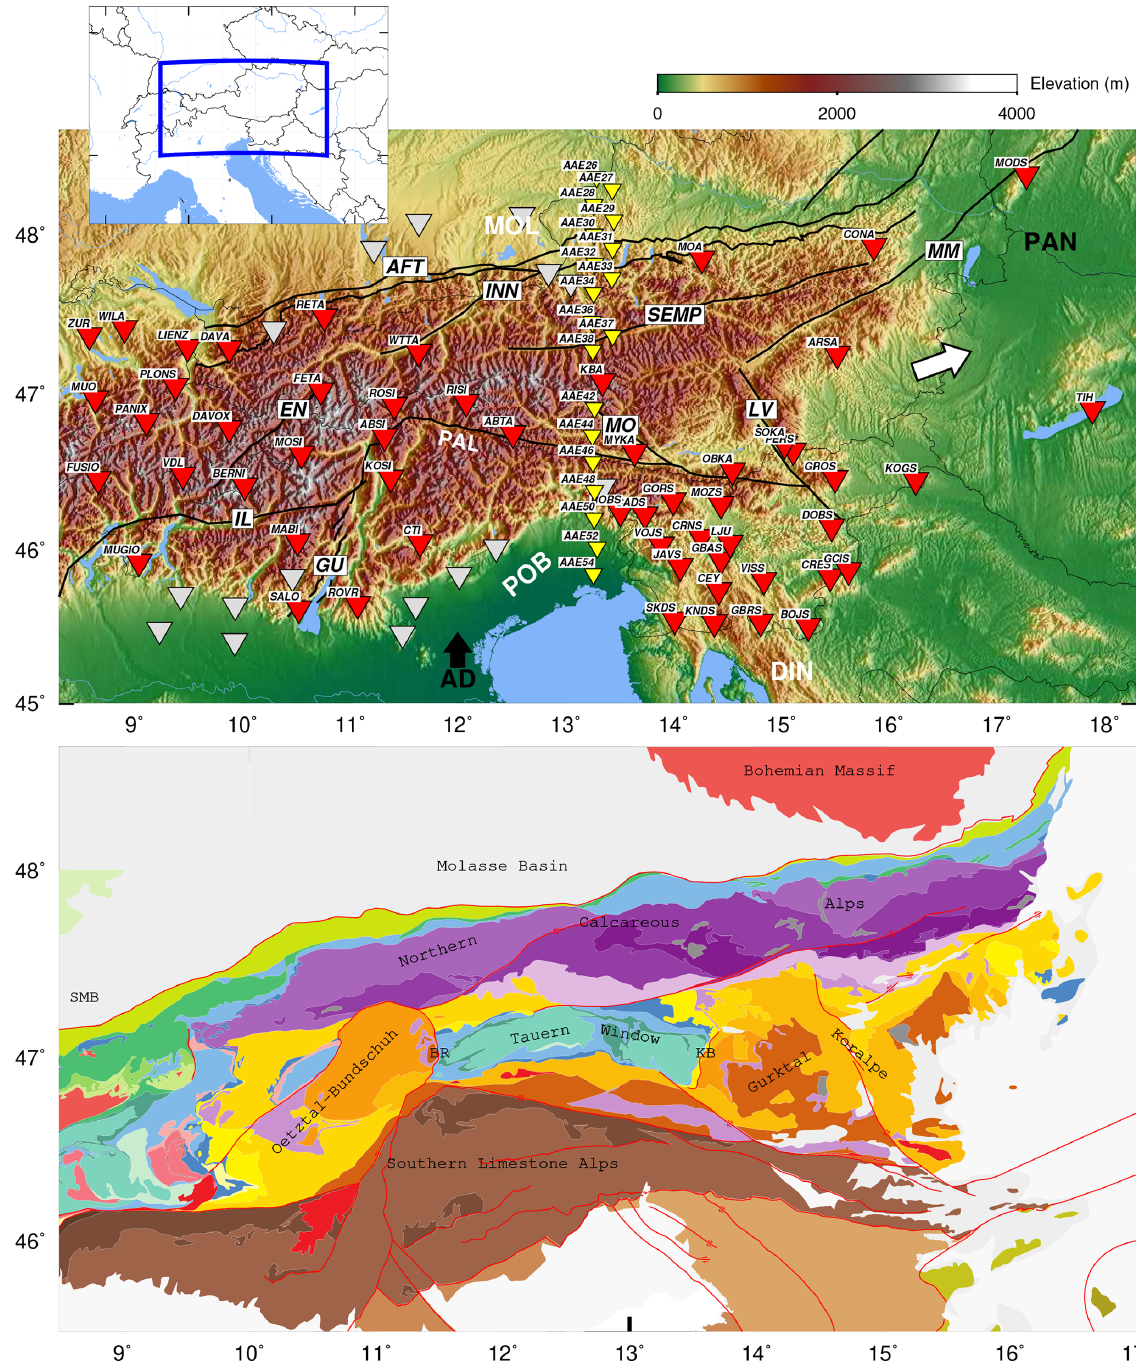
Figure 1. Study region in the Eastern and Southern Alps. Top: permanent stations are marked in red and grey, and the 19 EASI stations used are shown in yellow. Main faults of the region are represented by black lines. The faults are indicated as follows. AFT: northern Alpine Front Thrust, INN: Inntal, SEMP: Salzach–Ennstal–Mariazell–Puchberg, MM: Mur–Mürz, LV: Lavant Valley, MO: Mölltal, GU: Giudicarie, IL: Insubric, EN: Engadine, PAL: Periadriatic line. MOL: Molasse Basin, PO: Po Basin; PAN: Pannonian basin. DIN: Dinarides mountain belt. The black arrow shows the convergence vector of the Adriatic Plate (AD) with respect to the European Plate (EU). A white arrow illustrates the direction of eastward escape of the Alcapa tectonic block (see Sect. 6.4). After the different selection criteria, the stations shown in red and yellow were entered into the inversion (see text). Bottom: tectonic map of the study region (Schmid et al., 2004, 2008, from http://www.spp-mountainbuilding.de, last access: 17 September 2020). Units discussed in the text are labeled on the map. SMB: Swiss Molasse Basin, BR: Brenner fault, KB: Katschberg fault. Red lines represent the